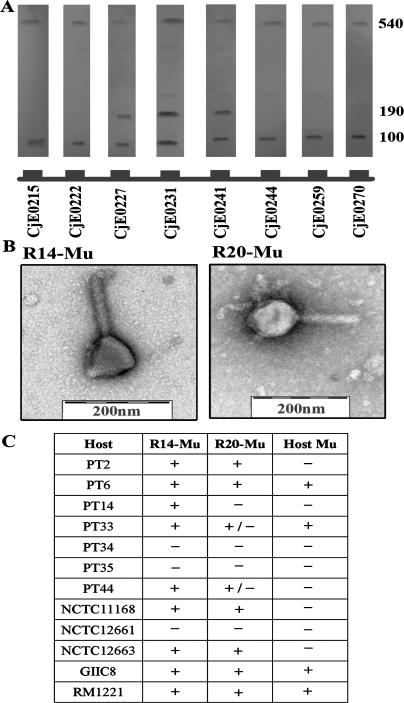
Presence and Recovery of Infectious CampMu Bacteriophage(A) Linear representation of the CampMu prophage from RM1221 with hybridisations against SmaI-digested PFGE-separated HPC5 genomic DNA using PCR-synthesised DIG-labelled probes for the genes indicated. The presence of a partial copy of the CampMu prophage in the 190-kb SmaI fragment containing genes CjE0225 to CjE0243 can be observed.(B) Transmission electron micrographs of the CampMu bacteriophage particles recovered from R14 (left) and R20 (right). The bacteriophages have icosahedral heads of 96–101 nm in diameter and tails 127–131 nm long by 21–25 nm wide.(C) The host range of R14-CampMu and R20-CampMu as determined by replication in liquid culture. The presence of CampMu prophage genes within the host (indicated by the “Host Mu” column) was determined by PCR on Campylobacter genomic DNAs using primers for genes CjE0222, CjE0233–CjE0237, and CjE0259 (Figure S9); and hybridisation of DIG-labelled probes of CjE0213, CjE0241, and CjE0259 to SmaI-digested PFGE-separated genomic DNAs (Figure S10).